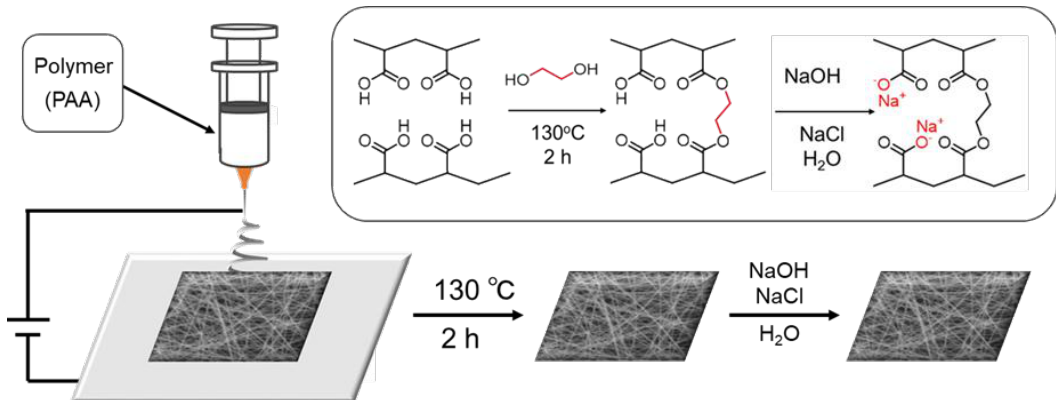
Figure 1. Schematic illustration of the fabrication process of a poly(sodium acrylate) (PSA) nanofiber mesh using the electrospinning